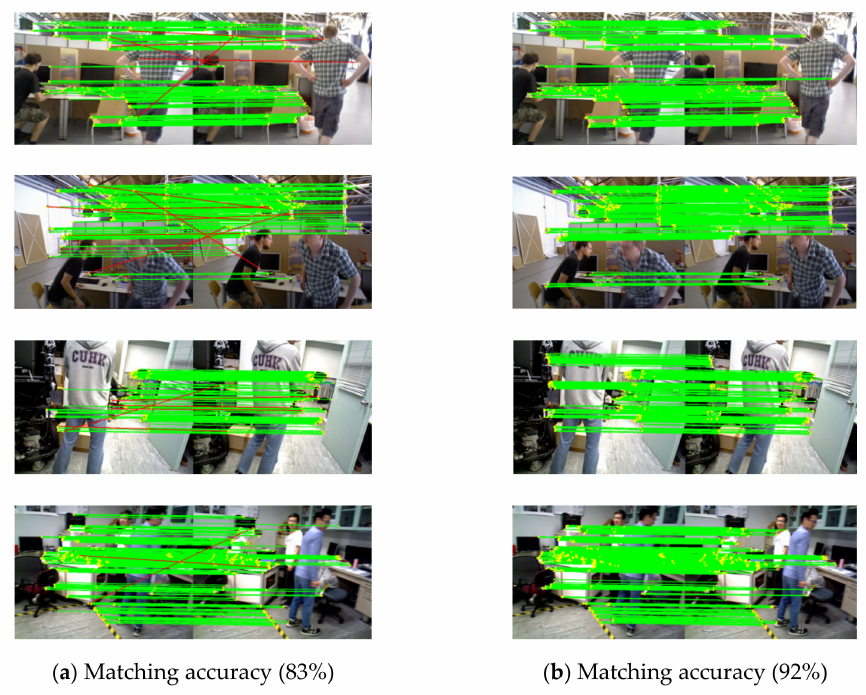
Figure 2. The comparison results of two matching algorithms. ( a ) RANSAC; ( b )